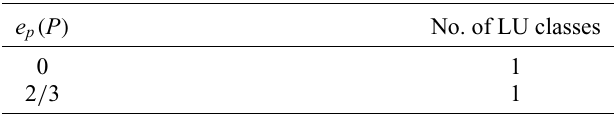
TABLE II. The entangling and LU classes of dual (equiva- lently, T dual) permutations in P ( 4 )